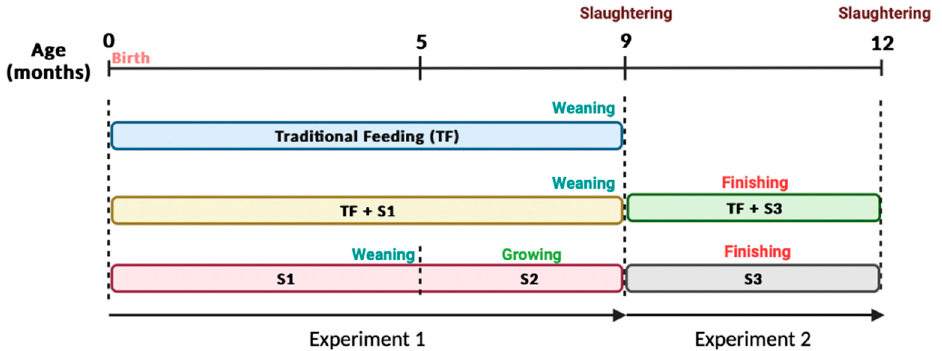
Figure 2. Study design for experiment 1 and experiment 2. Experiment 1 was composed of three groups: TF, animals fed with traditional feeding, weaned, and slaughtered at 9 months; TF + S1, animals were produced in the same way as the TF group but supplemented with a starter supplement (S1); and S1 + S2, fed with S1 until weaning at 5 months and with a growth supplement until slaughter at 9 months. Experiment 2 had two groups: TF + S3, animals weaned by the traditional way and fed with a finishing supplement (S3); and S3, animals finishing with the S3 supplement.